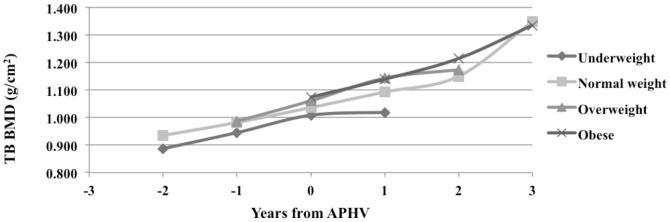
TB BMD changes during pubertal growth spurt.Comparing four different groups – underweight, normal weight, overweight and obese pubertal boys. APHV - age of peak height velocity.